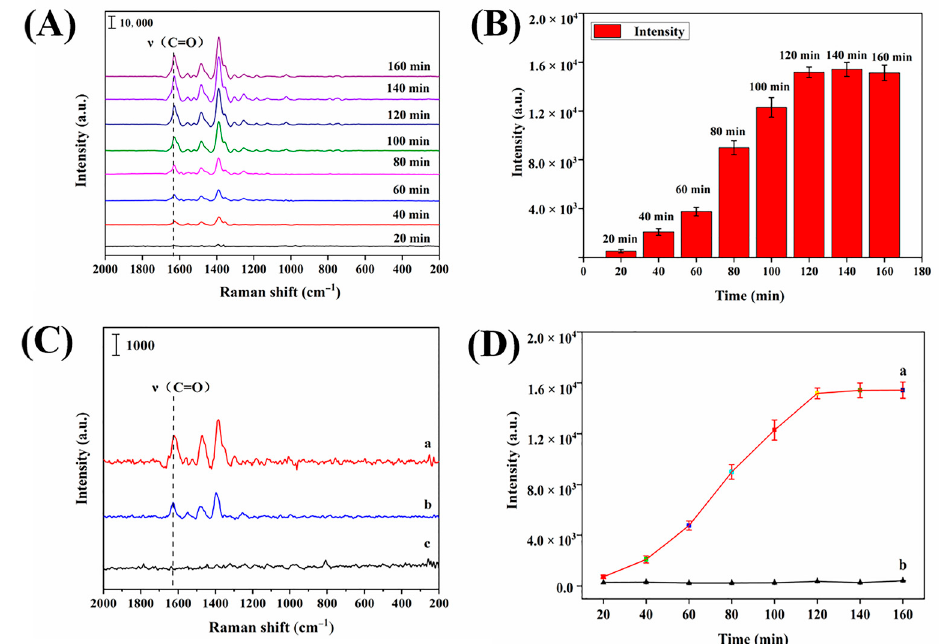
Figure 4. ( A ) SERS spectra obtained at different adsorption times for 1 μ g/mL ENRO absorbed on Ag NPs–MIPs film as substrate. ( B ) Effect of adsorption time on the SERS intensity of ENRO. ( C ) SERS spectra of 1 μ g/mL ENRO absorbed by Ag NPs film as substrate (a), 1 μ g/mL ENRO